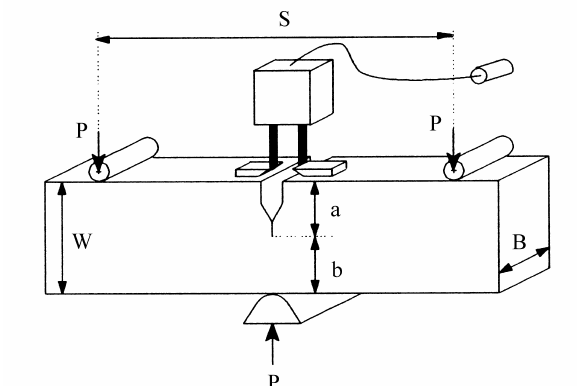
Figure 7. SE(B) specimen.